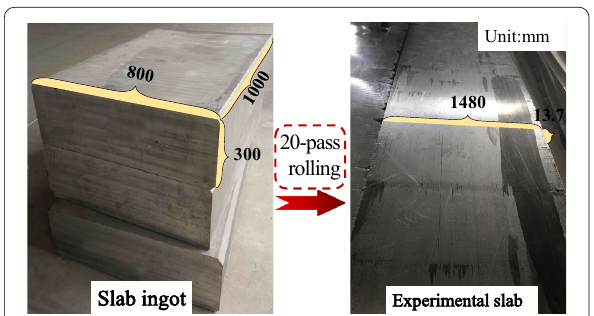
Figure 2 Microstructure of a 13.7-mm-thick sample in the TD-ND